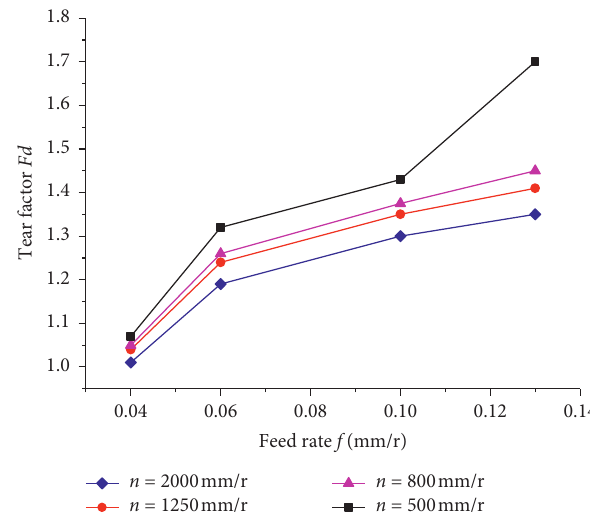
Figure 24: Tear factor Fd at the varying experimental parameter